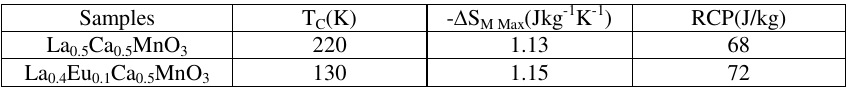
∆ S Table 3: T C , - max , and RCP values for La 0.5-x Eu x Ca 0.5 MnO 3 (x=0 and 0.1) for an applied field of